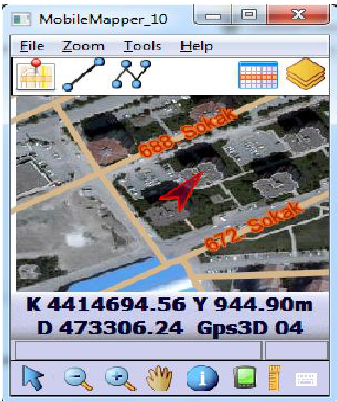
Figure 17. GPS hand unit and orthophoto web service